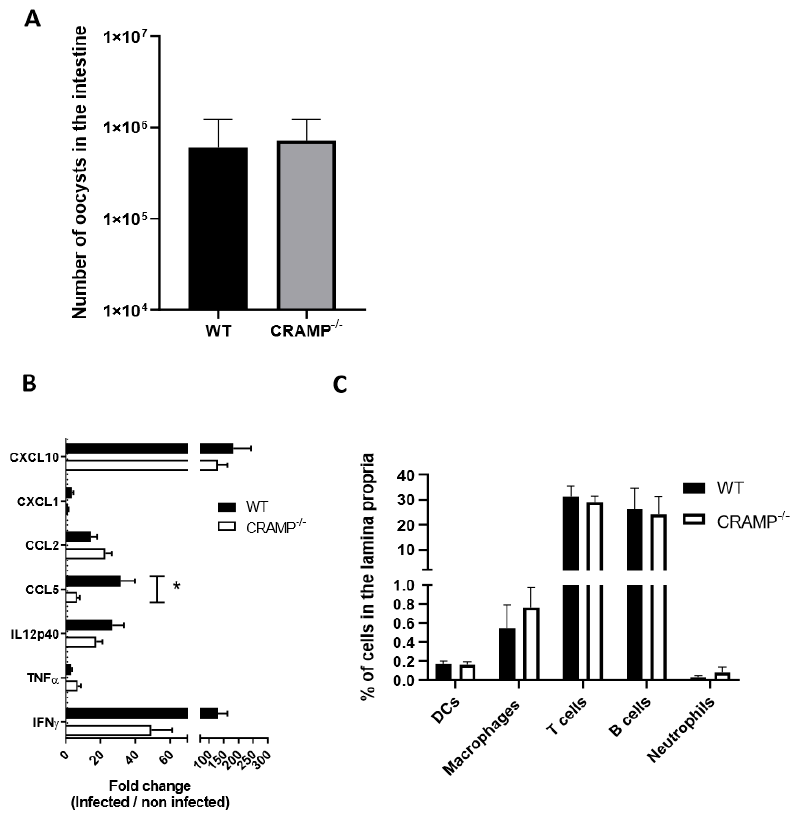
Figure 2. CRAMP deficiency did not increase the number of intestinal parasites. Three-day-old C57BL/6J and CRAMP − / − neonates were orally infected with 5.10 5 oocysts of C. parvum . ( A ) Parasitic load was evaluated in the intestines of neonatal mice after 5 days of infection. Mann–Whitney non-parametric test * p < 0.05. There were three repetitions of this experiment and the graph represents the cumulative data (n = 35). ( B ) qRT-PCR analyses of proinflammatory cytokine and chemokine expression in the ileum were performed in C57BL/6J and CRAMP − / − neonates at day 5 pi (n = 6 mice per group). ( C ) The intestinal recruitment, induced by CRAMP, of dendritic cells, macrophages, T and B cells, and neutrophils was analyzed by flow cytometry in C57BL/6J and CRAMP − / − neonates at day 5 pi (n = 6 mice per group). Mann–Whitney non-parametric test * p < 0.05. These data are from one experiment representative of two.